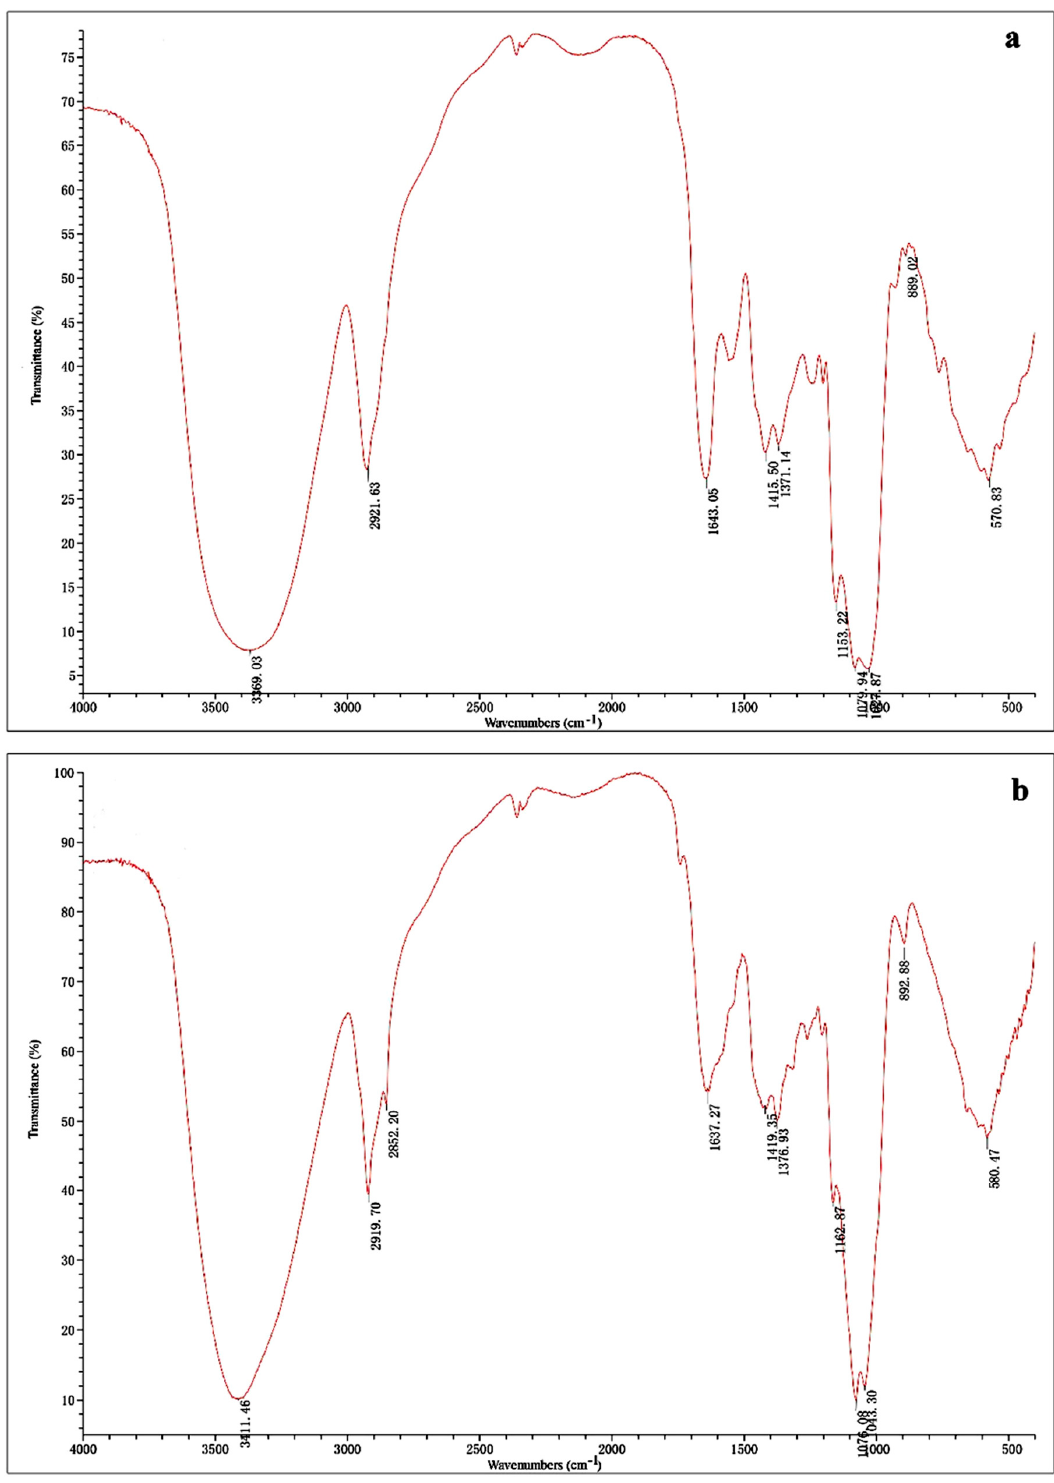
Figure 1. FT-IR spectrum of ( a ) ORWP and ( b ) ORAP.